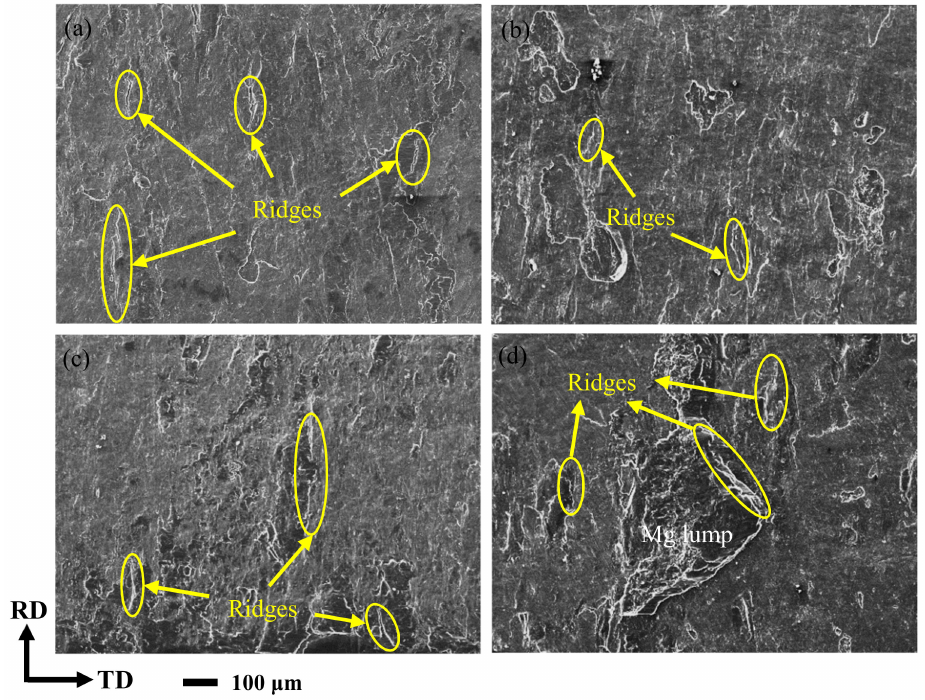
Figure 9. Tensile-shear fracture SEM images on the Al-side of the corrugated Mg/Al clad plate along the TD: ( a ) front waist, ( b ) peak, ( c ) back waist, ( d )